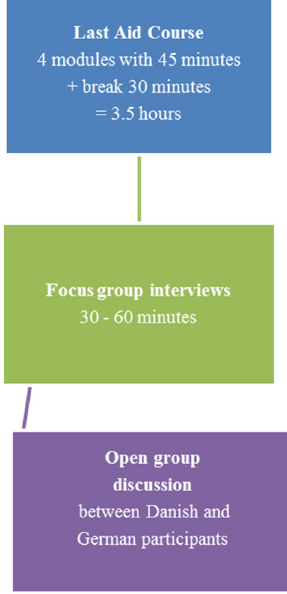
Figure 1. Overview of the one-day Last Aid